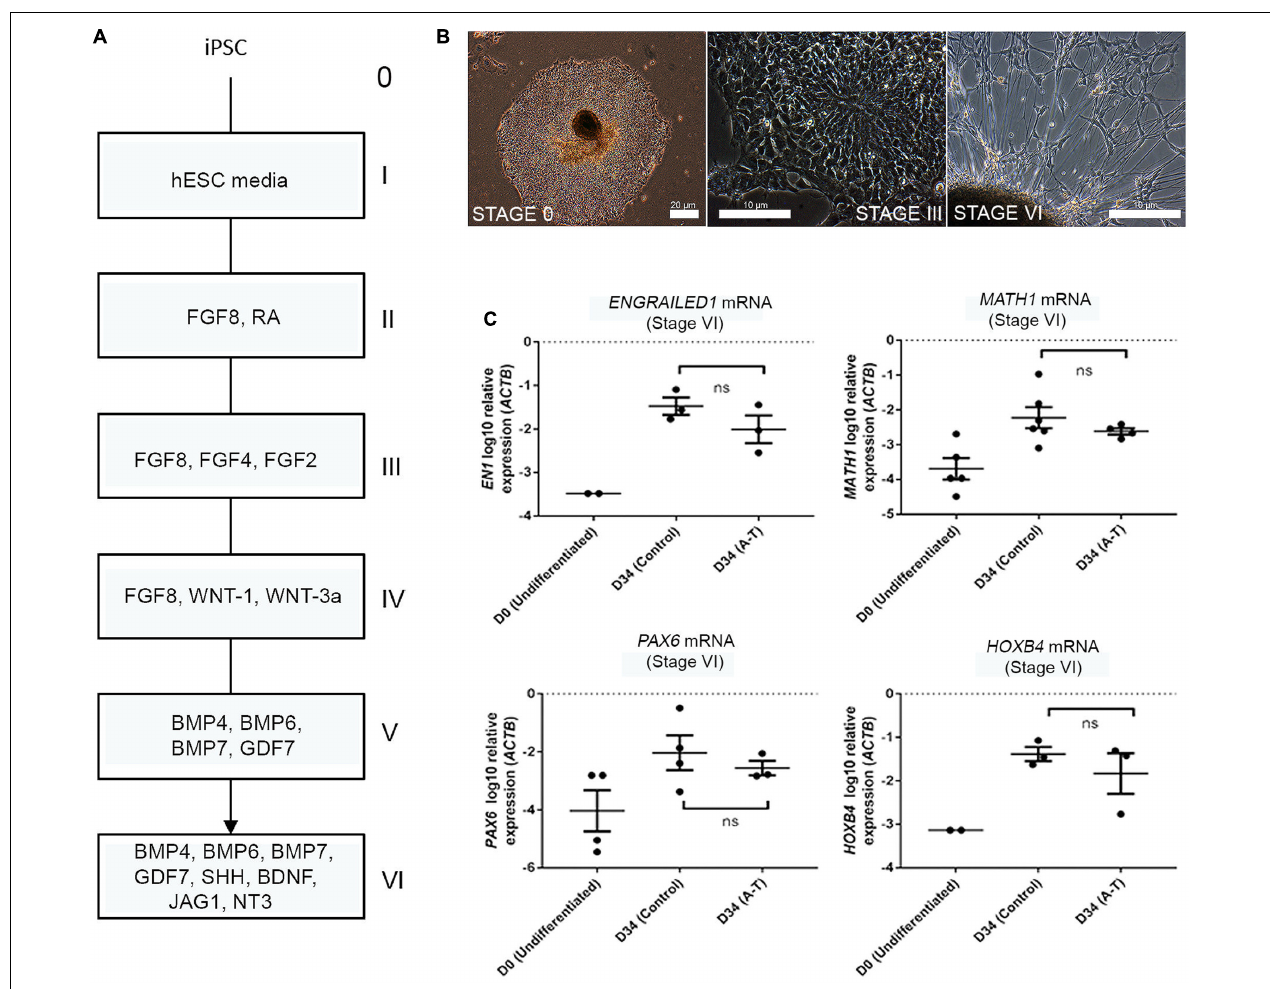
FIGURE 2 | Cerebellar differentiation of control and A-T iPSCs (A) schematic detailing differentiation protocol. Individual stages are denoted by roman numerals; boxes show relevant growth factors/recombinant proteins used at each stage. (B) Representative phase-contrast photographs of stage I (undifferentiated iPSCs), stage III (polarized neuroepithelia/rosettes) and stage VI (final plating stage, showing mixed aggregate/monolayer culture). (C) Upregulation of EN1, MATH1, PAX6 and HOXB4 mRNA is comparable between A-T and control iPSCs following 34 days of differentiation (stage VI). Samples were normalized to ACTB and show SEM from independent differentiation experiments comprising between 3 to 6 control/A-T differentiations. Values for neural-specific markers in which day 0 samples did not generate C t-values have not been included. p -values = EN1 (0.4, ns), MATH1 (0.3524, ns), PAX6 (0.6286, ns), HOXB4 ( > 0.999, ns), unpaired t -test,